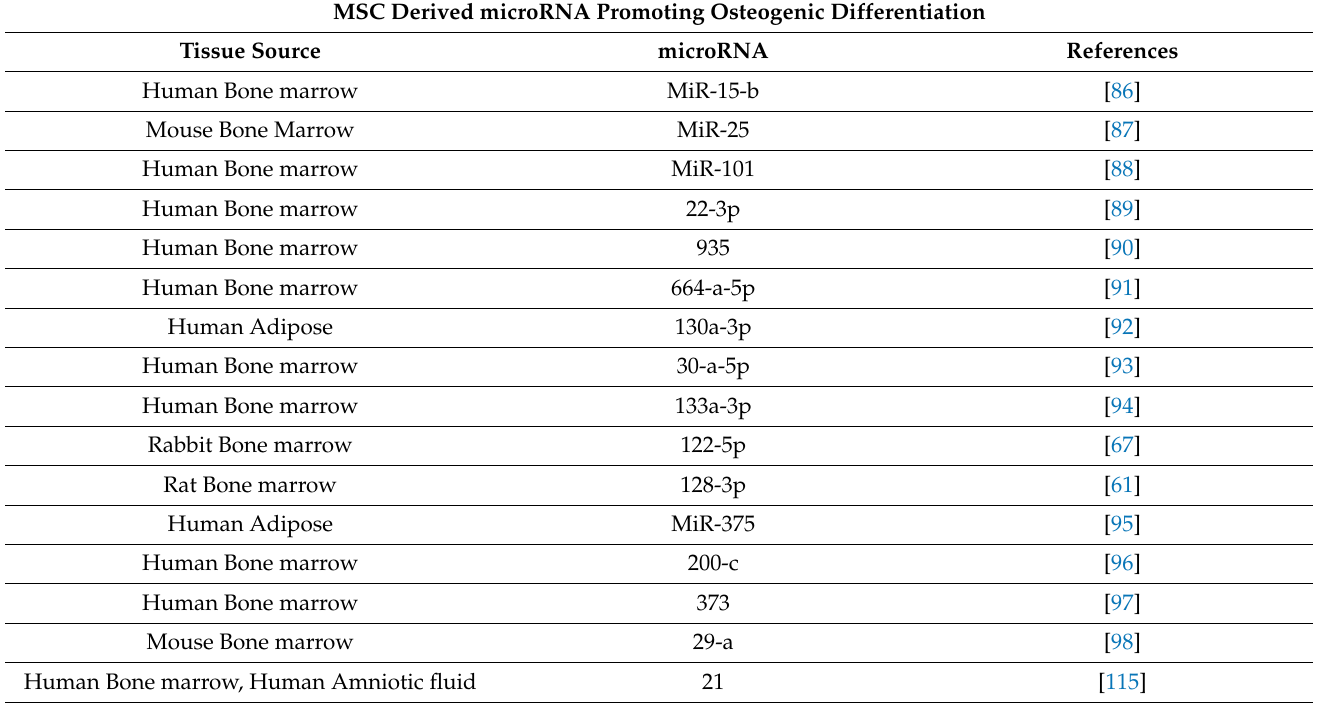
Table 3. MSC-derived exosome miRNA promoting and inhibiting osteogenic